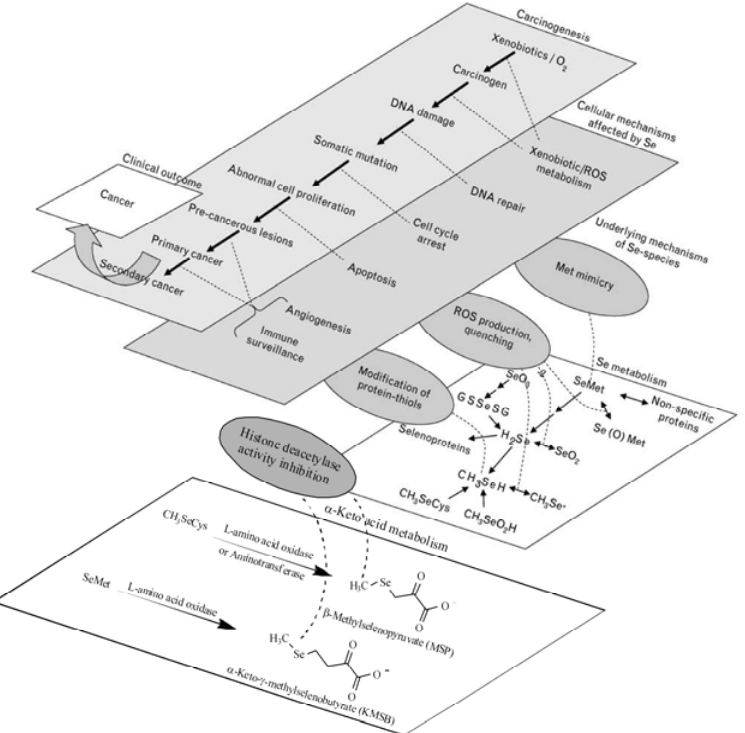
Figure 1. A multi-tiered model of Se